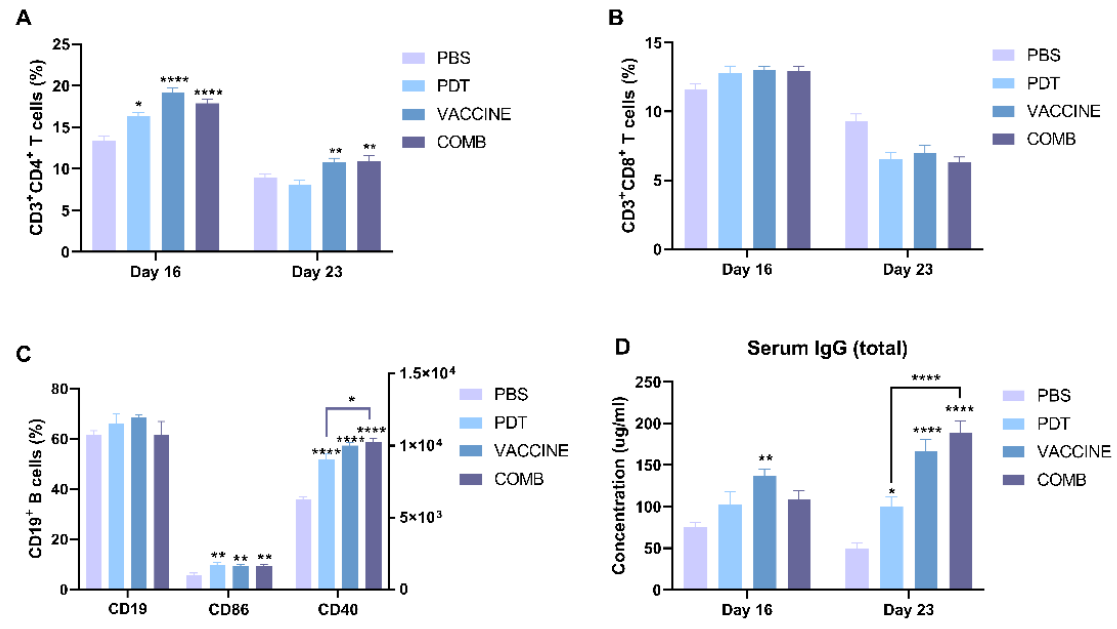
Figure 6. The combination of FOSCAN-PDT and HBc VLPs induces anti-tumor immune responses. ( A ) The percentage of CD4 + T lymphocytes and ( B ) CD8 + T lymphocytes in the blood of mice injected with different treatments (n ≥ 6). ( C ) The CD3 - CD19 + population and gMFI of CD40 and CD86 on these cells in blood lymphocytes of MC-38 tumor-bearing mice in different subgroups (n ≥ 6). ( D ) Total serum IgG concentrations of MC-38 tumor-bearing mice in different groups (n ≥ 6) were assessed by ELISA. Statistical significance was calculated using a one-way ANOVA. Statistical differences are denoted as * p < 0.05, ** p < 0.01, and **** p < 0.0001.